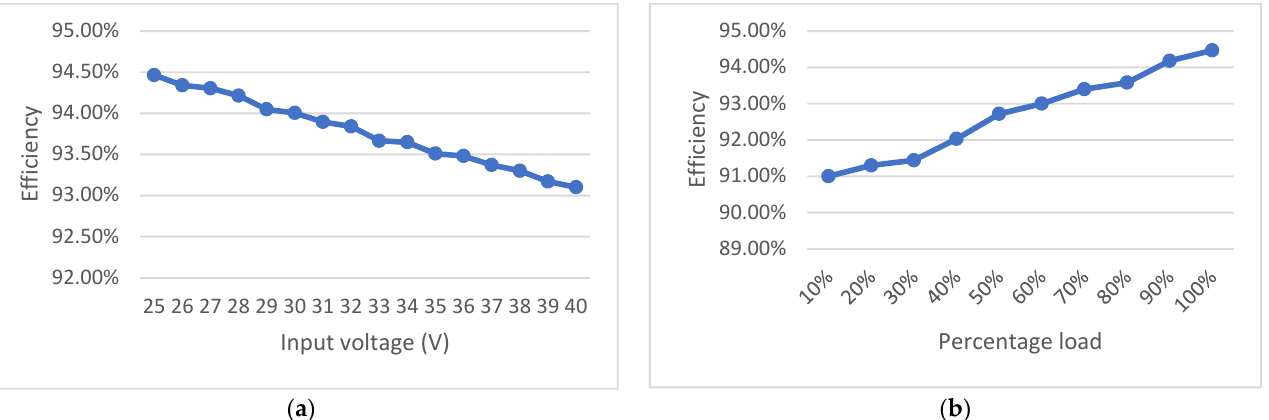
Figure 14. Efficiency test of the converter. ( a ) Efficiency test for different bus input voltages. ( b ) Efficiency test for different loads.